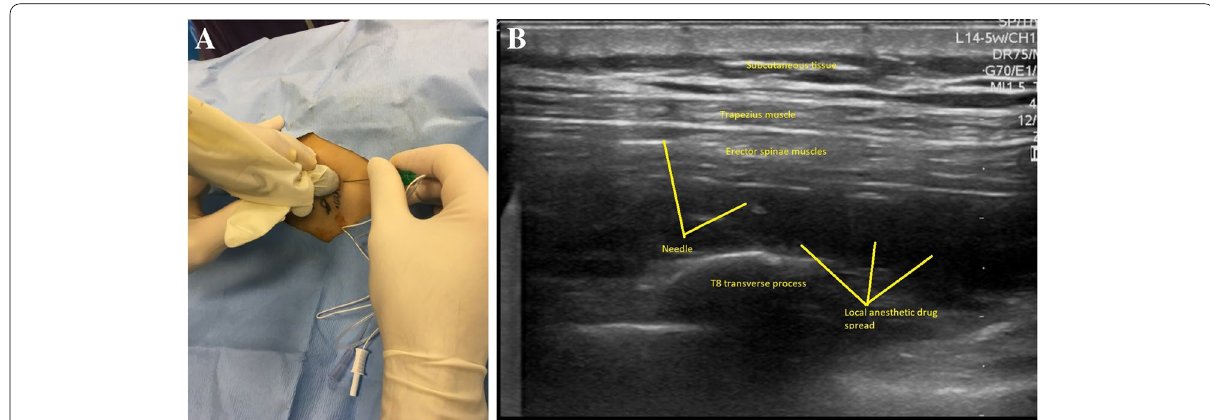
Fig. 1 Ultrasound-guided demonstration of the erector spinae plane block. A The patient was placed in the lateral decubitus position after anesthesia induction. The ultrasound lineer probe is placed in a longitudinal parasagittal orientation. B The block needle is inserted in plane in a cranial-to-caudal direction to contact the transverse processes. Needle location indicated by arrows with LA deposited deep to the erector spinae